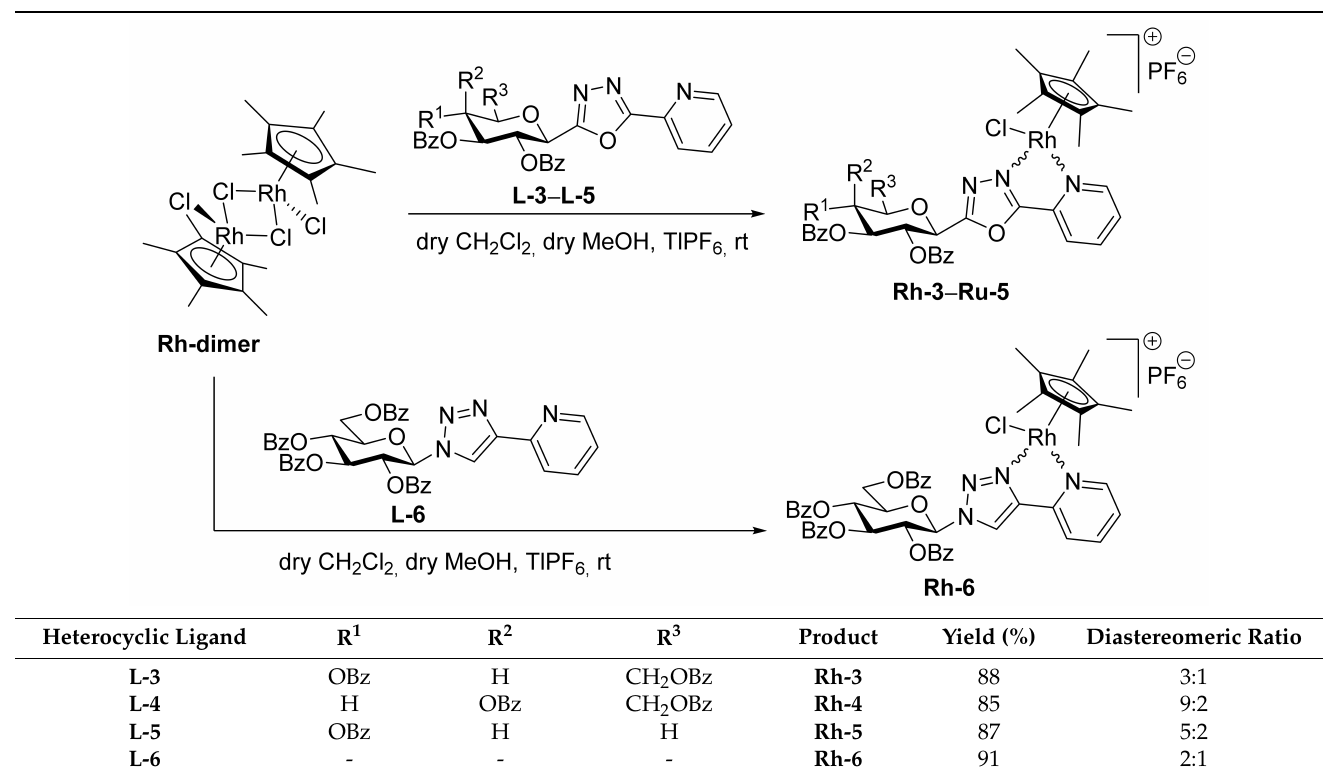
Table 3. Synthesis of [( η 5 -Cp*)Rh III (N-N))Cl]PF 6 complexes containing O -perbenzoylated C - and N -glycosyl